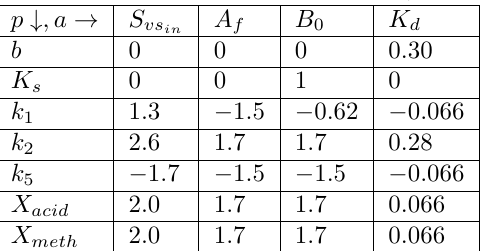
Table 8: Relative sensitivities S a,b